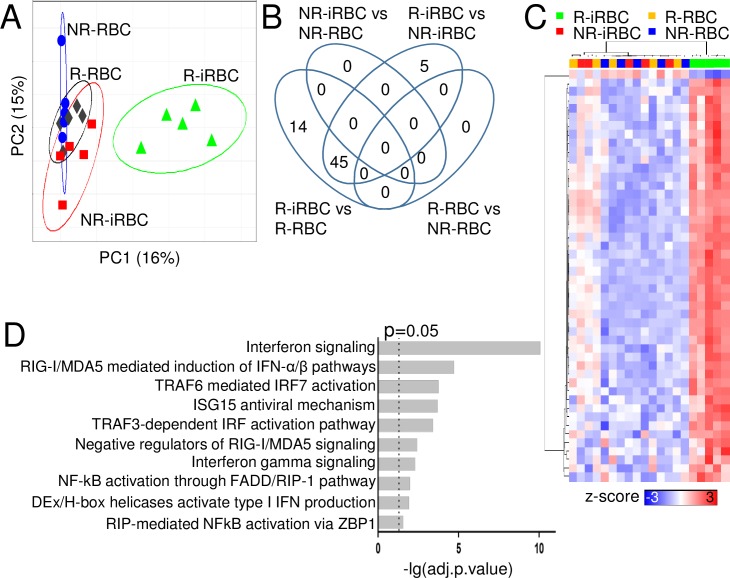
Transcriptional analysis of NK cells in response to RBCs and iRBCs.NK cells from five responders and five non-responders were co-cultured with either iRBCs or RBCs for 96 h. NK cells were purified from the four cultures for RNA isolation, cDNA library construction and microarray analysis. (A) sPLS-DA supervised clustering of the indicated conditions. (B) Pairwise comparison of all groups. (C) Heatmap of expression levels of identified DEGs. Each row represents a gene and each column represents a sample of the indicated group. Hierarchical clustering of columns and rows were performed using Euclidean distance and represented as a dendrogram. The organization and length of the branches in the dendrogram reflect similarities in gene expression profiles. (D) Top 10 pathways obtained from functional network-based analysis of the DEGs in R-iRBC samples.